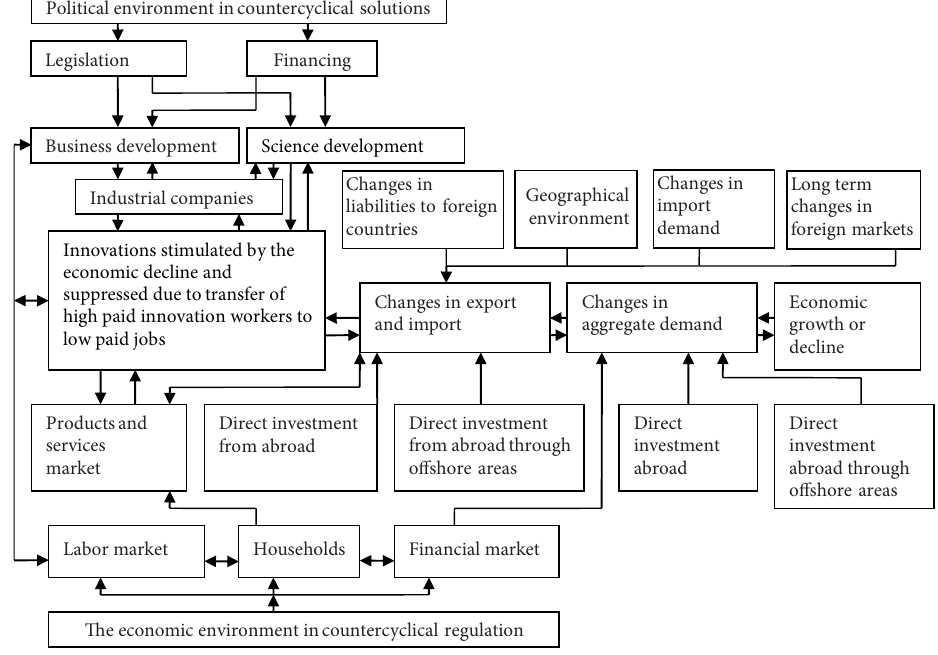
Fig. 7. Impact of innovations on international competitiveness during economic